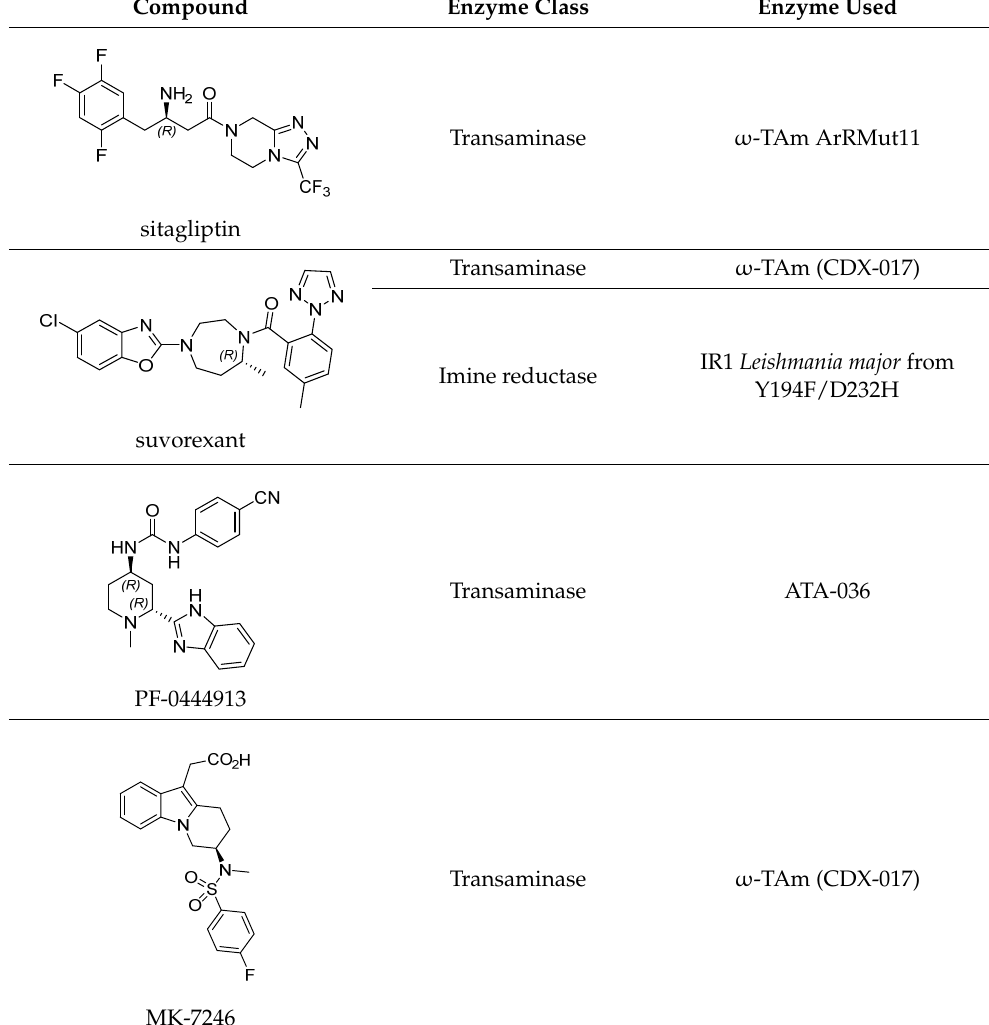
Table 1. List of compounds discussed in this review and enzymes used during their